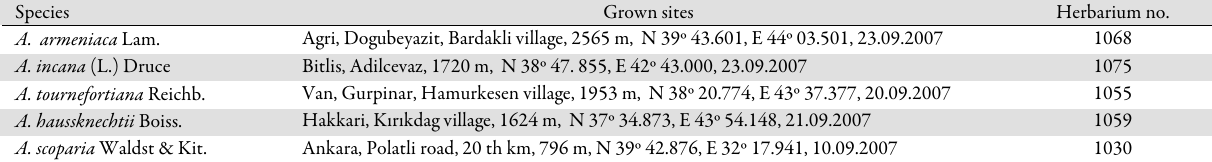
Table 1. Grown site of investigated Artemisia species Species Grown sites